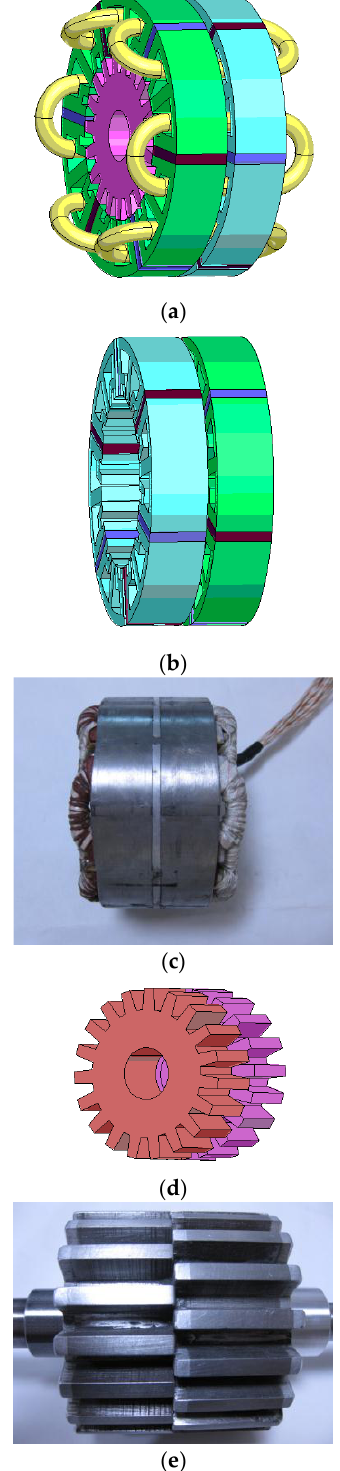
Figure 4. MTFTSFM: ( a ) The machine structure; ( b ) The stator structure; ( c ) Prototype stator; ( d ) The rotor structure; ( e ) Prototype rotor.